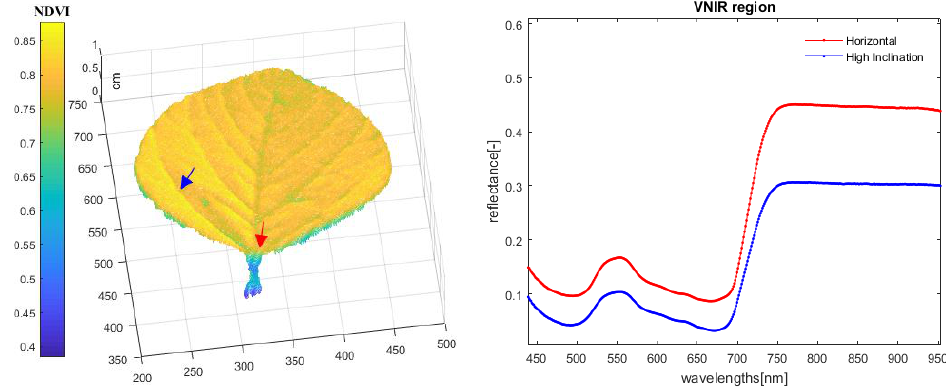
Figure 10. Soybean leaf hyperspectral 3D model, based on the fusion model proposed in this paper.